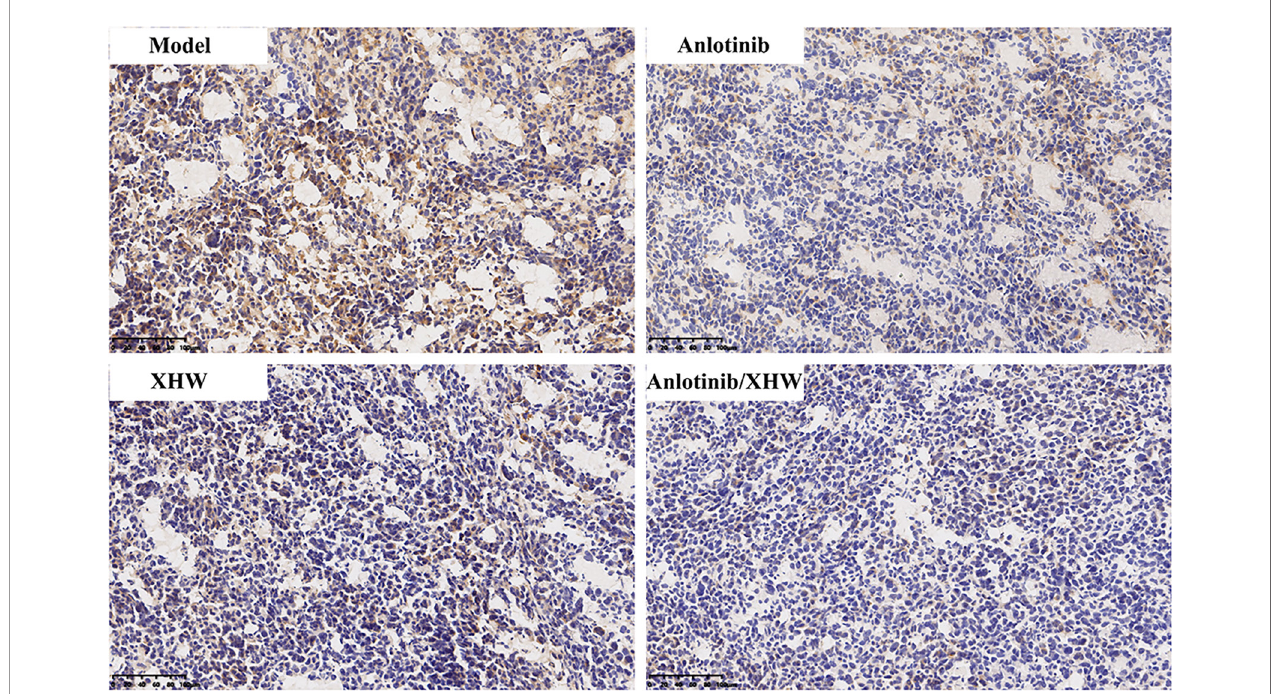
FIGURE 7 | Effects of anlotinib and XHW on the expression of PDGFRA in the treatment of lung cancer by immunohistochemistry